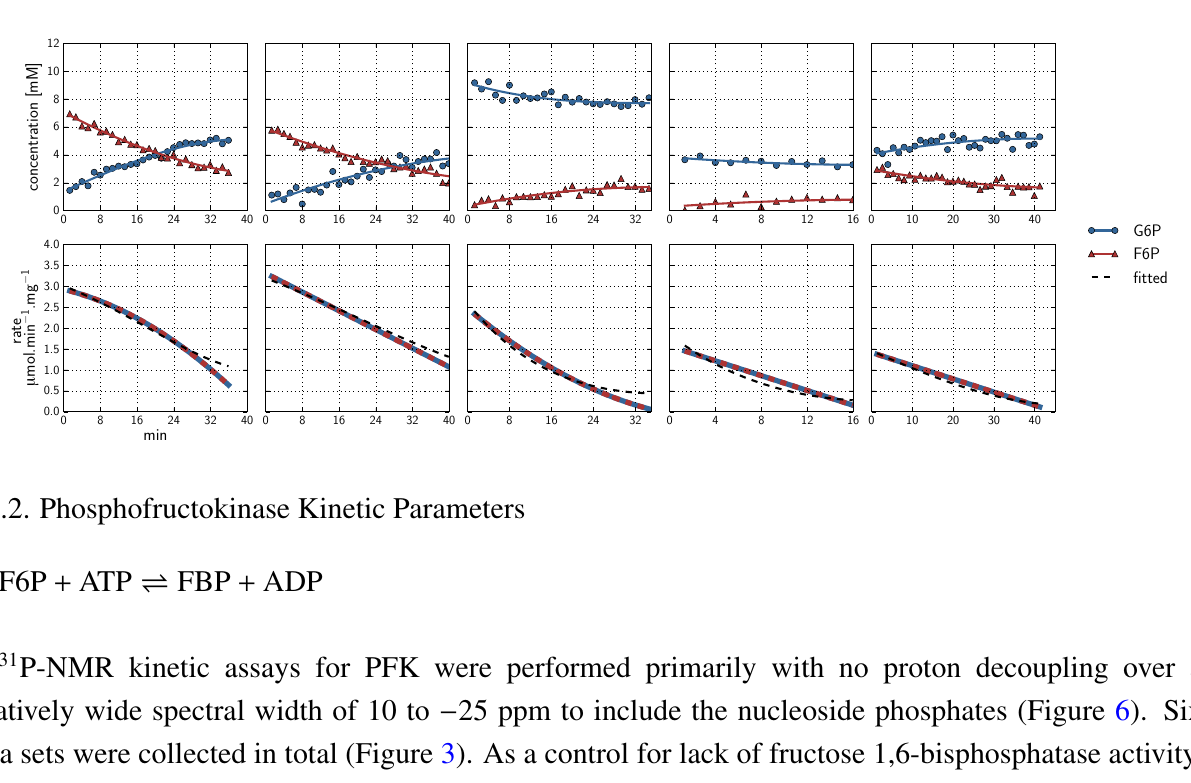
Figure 5. Spline fits of Phosphoglucose Isomerase data. Top row: Time courses of the PGI reaction were acquired by incubating a cell extract with various starting concentrations of substrate G6P ( (cid:4) ) and product F6P ( (cid:78) ) and monitoring reaction progress using 31 P NMR with a 90 ◦ pulse angle and 1 s repetition time (1.0 s acquisition, 0.0 s relaxation) with 80 transients per FID. Other parameters are as described in Section 3.3. Progress curves derived from NMR peak integrals were fitted with splines (G6P —, F6P —). Bottom row: The respective averaged rates of the fitted splines are plotted (dual colours indicate average of two respective rates) with the rate of the fitted kinetic equation included (- - -, Table 1: PGI). Rates were normalised to total protein content. Raw NMR FID data, as well as NMR peak integrals and spline data, are included as supplementary